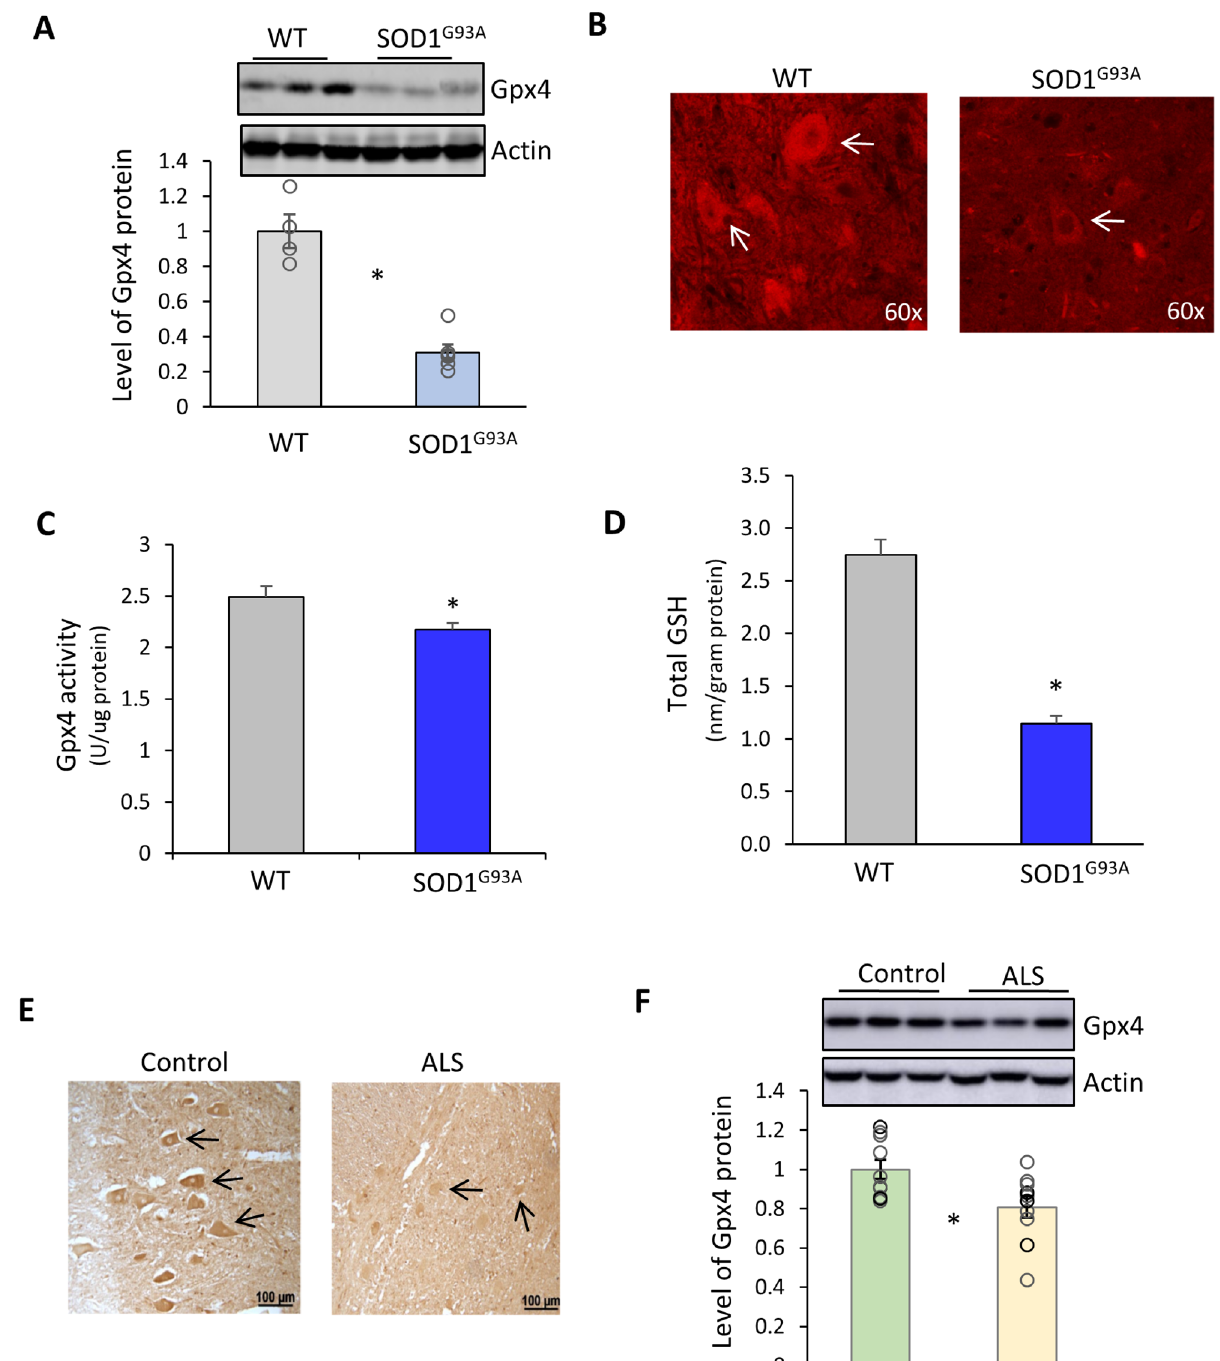
Figure 6. Deficiency of Gpx4 in the spinal cords of symptomatic SOD1 G93A mice and of ALS patient samples. ( A ) Graph of western blots showing reduced level of Gpx4 protein in spinal tissues of symptomatic SOD1 G93A mice (120 days of age). n = 4 for WT and 6 for SOD1 G93A . *: p < 0 .05. ( B ) Immunofluorescence images of lumbar spinal cord sections from WT and SOD1 G93A mice stained with an anti-Gpx4 antibody. Arrow heads indicate motor neurons. ( C ) Gpx4 activities in spinal protein extracts of WT and symptomatic SOD1 G93A mice. ( D ) Graph indicating total GSH levels in lumbar spinal cord tissues of WT and symptomatic SOD1 G93A mice. n = 4 for WT and 6 for SOD1 G93A . *: p < 0.05. ( E ) Representative images of spinal cord sections of ALS and Control (non-ALS) cases stained immunohistochemically with an anti-Gpx4 antibody. Arrow heads indicate motor neurons. ( F ) Graph of western blots showing reduced levels of Gpx4 protein in spinal tissues from ALS cases compared to Control (non-ALS) cases. n = 10, *: p < 0